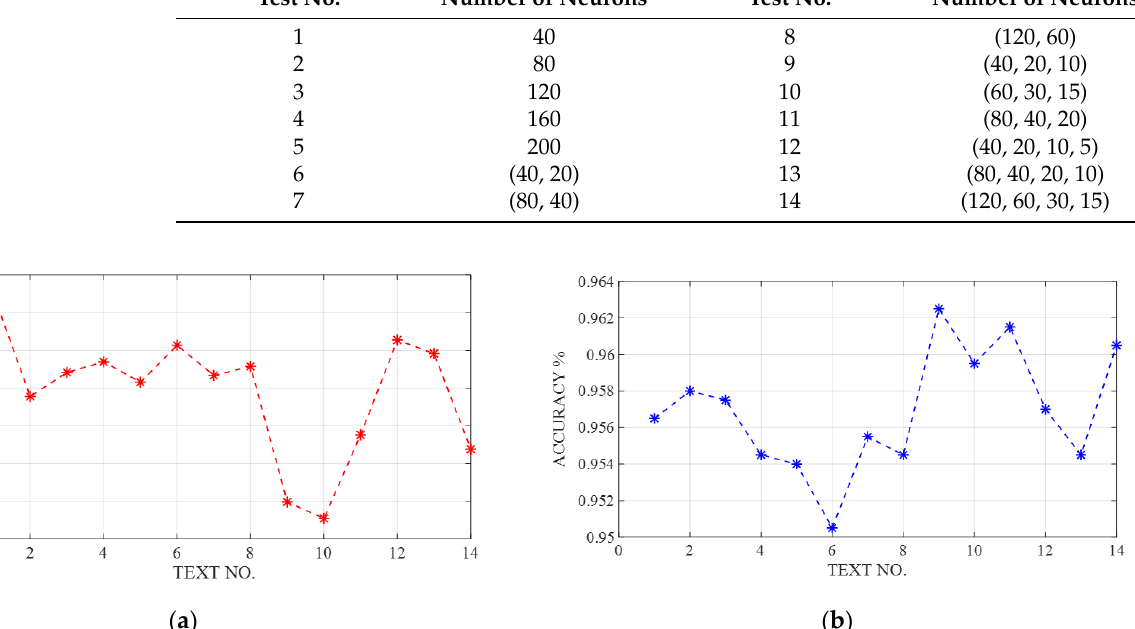
Figure 6. Parameter settings and test results ( a ) loss value; ( b ) accuracy.